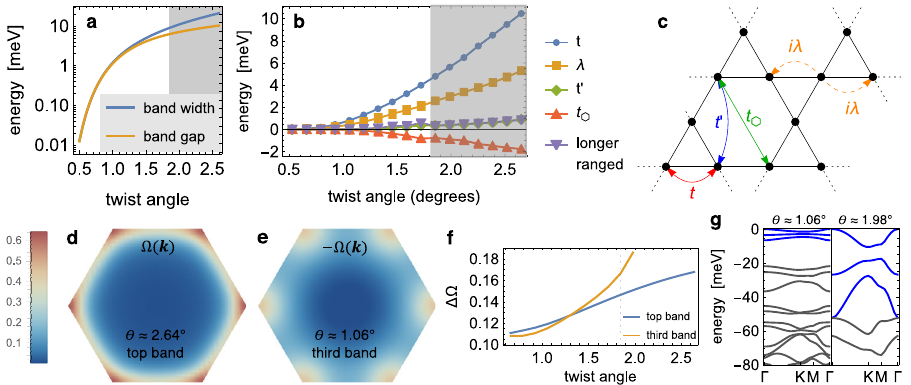
Fig. 3 Twist angle dependence of the Kagome moiré lattice. a Band width and energetic separation of the top-most moiré valence band, extrapolated from the continuum theory as a function of twist angle. b Kagome tight-binding parameterization of the top three moiré bands, with real and imaginary hoppings depicted schematically in c . Shaded regions denote larger twist angles for which the third Kagome band does not remain well-isolated from lower-lying states; tight-binding parameterization in this region fi ts only the top two bands. d Berry curvature at 2.64 ∘ for the fi rst moiré Kagome valence band, as well as e for the third band at 1.06 ∘ . f Berry curvature fl uctuations ΔΩ are suppressed as the twist angle is reduced, approaching a moiré realization of a Landau level. g Band structure of the continuum model at θ ≈ 1.06 ∘ , 1.98